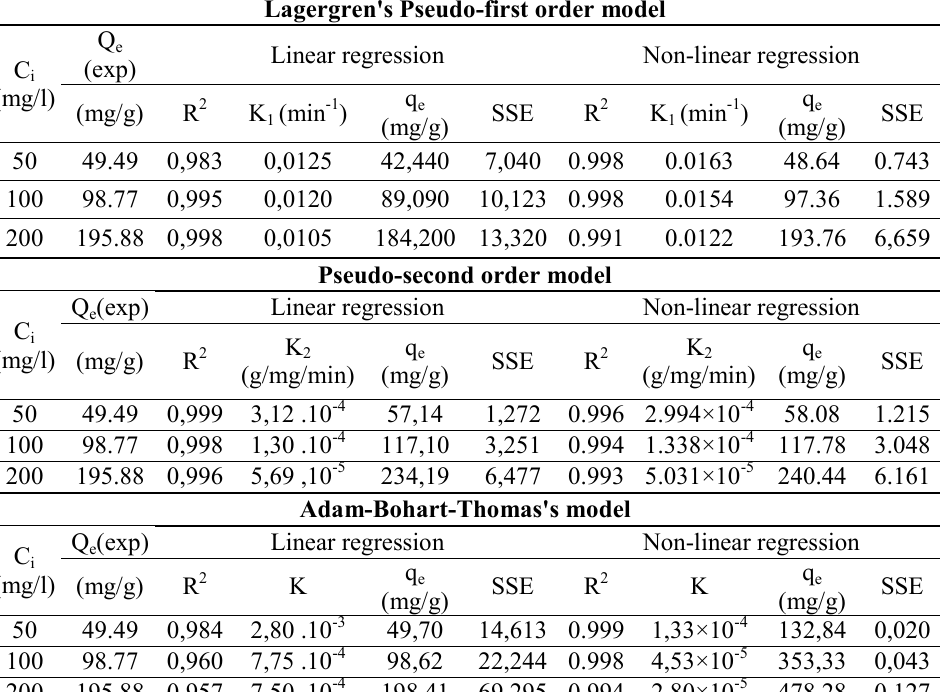
Table 2. Kinetic data obtained by linear and non-linear regression of three kinetic